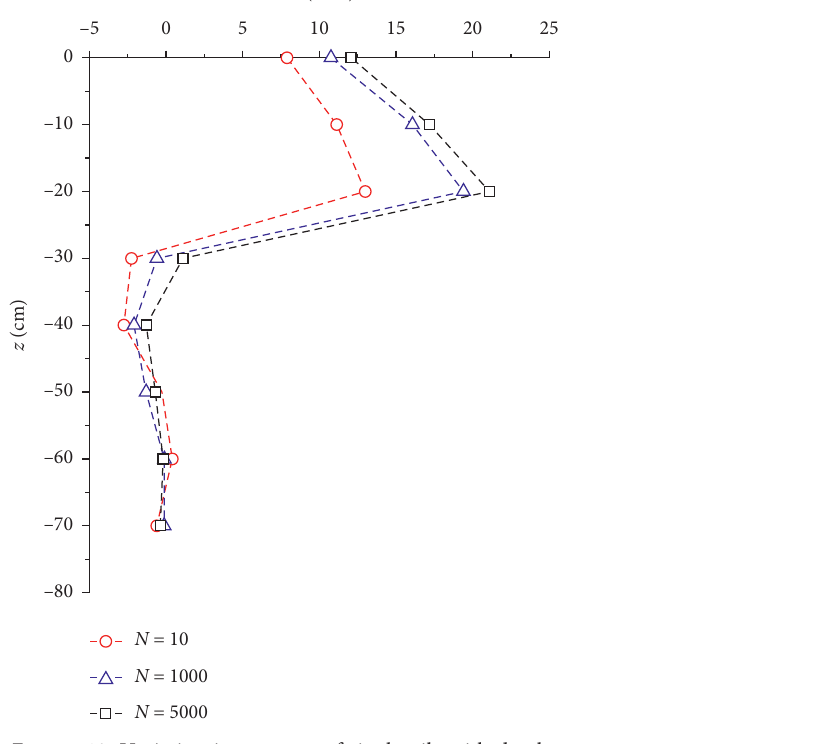
Figure 12: Variation in moment of single pile with depth.